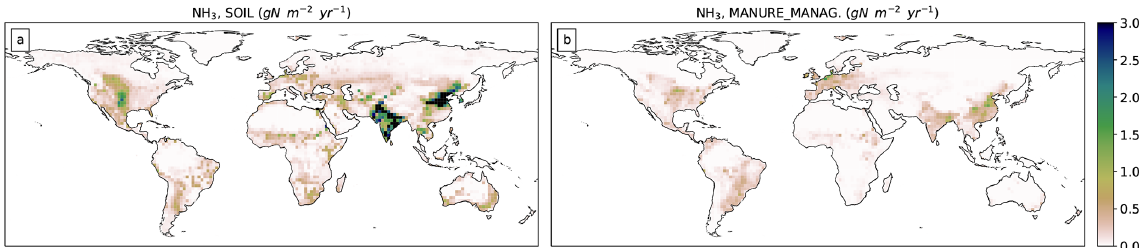
Figure 6. Simulated ammonia emissions averaged over the 2005–2015 period (gNm − 2 yr − 1 ) from agricultural soil (fertilizer and manure application) (a) and manure management (b) .